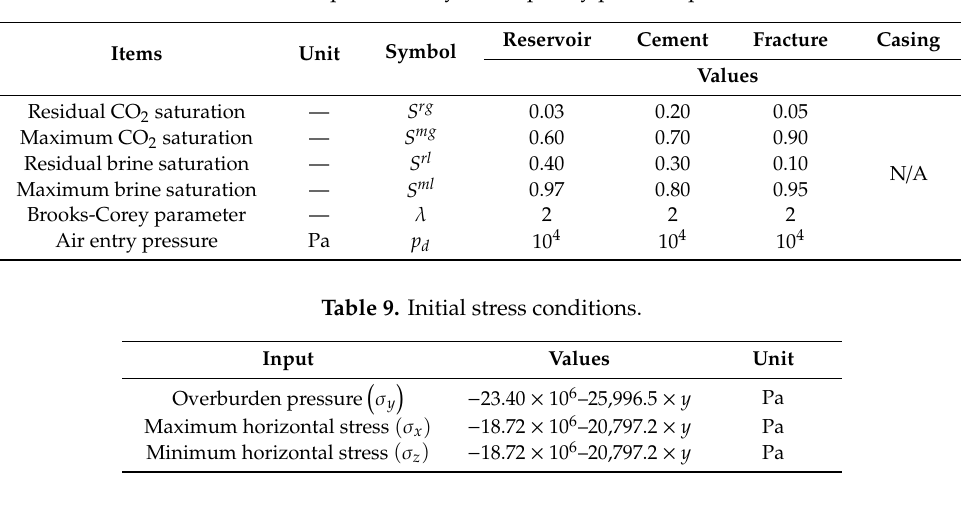
Table 8. Relative permeability and capillary pressure parameters.